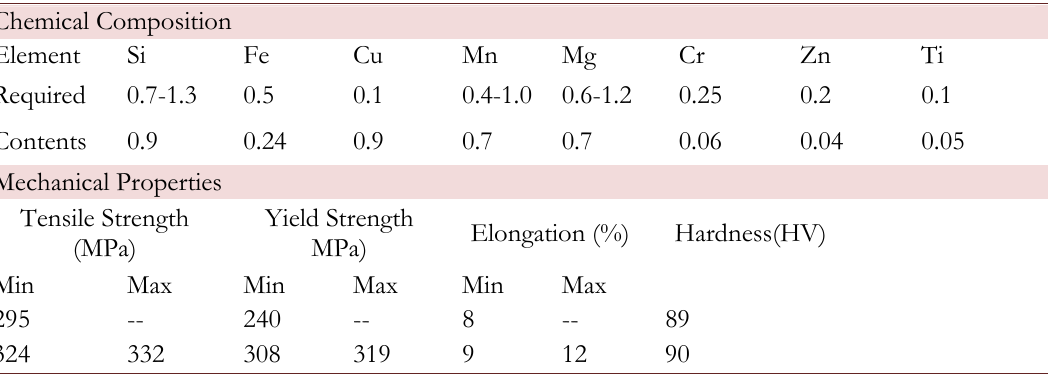
Table 1: Chemical composition and mechanical properties AA6082-T6.